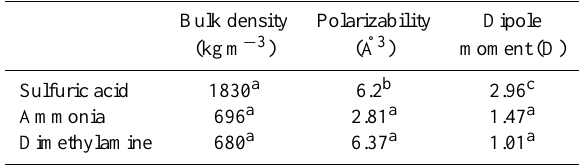
Table 1. Properties of the modeled